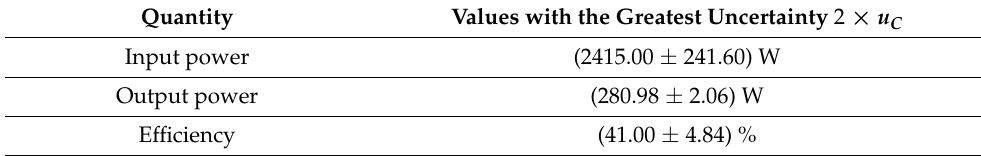
Table 5. Maximum values of the expanded uncertainty of the